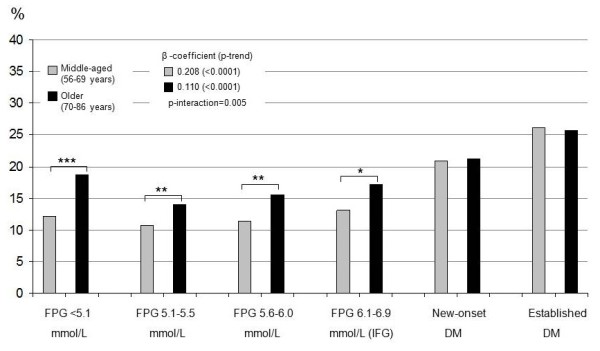
Proportion of men reporting low self-rated health. The figure shows the proportion of men reporting low SRH for each of the six glucometabolic status groups defined in the text. β-coefficients and p-values for trends from the 1st to the 6th groups are also shown. Brackets denote differences between age groups within each glucometabolic status group. * p < 0.05; ** p < 0.01; *** p < 0.001.